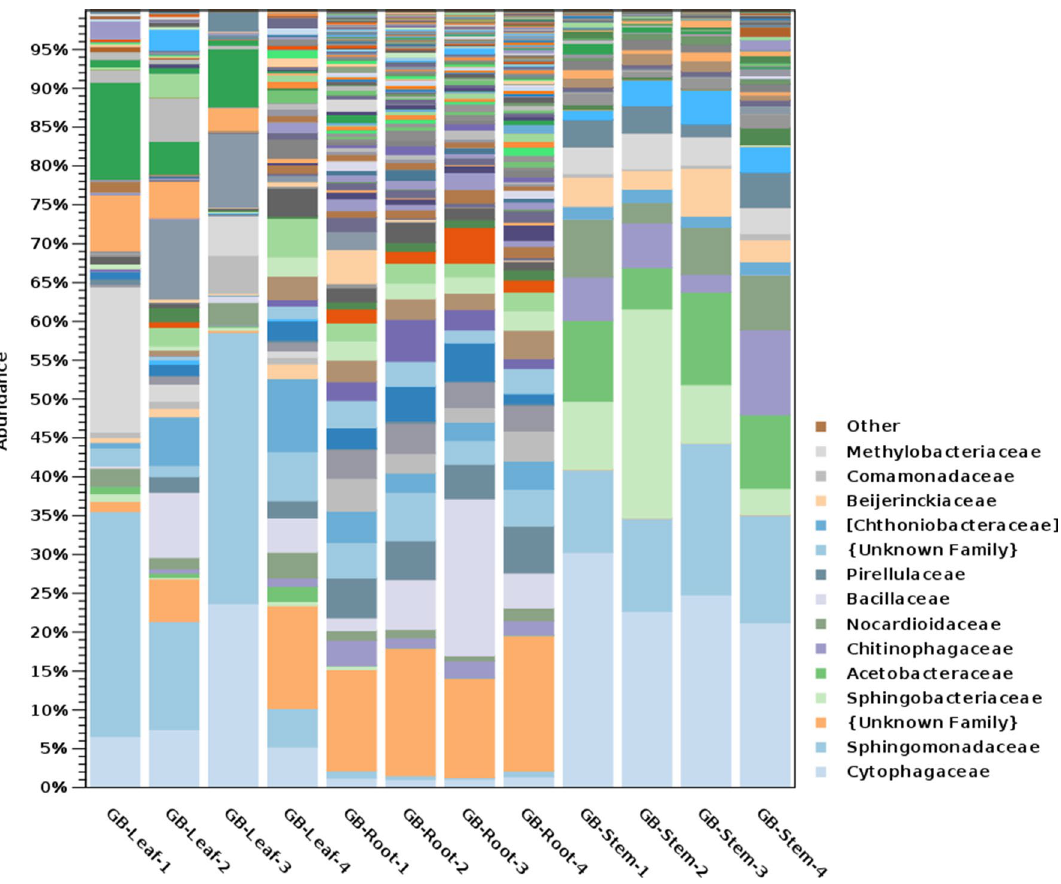
Figure 7. Taxonomic abundance of bacterial families in Ginkgo biloba